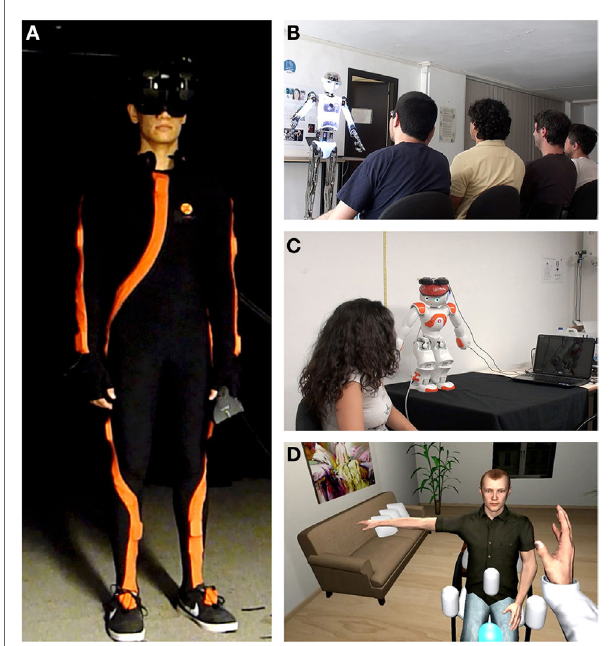
FigUre 4 | images from the transporter and all three destinations . Clockwise from left: (a) the visitor wears the Xsens Inertial motion capture suit and the NVIS nVisor SX111 HMD at the transporter; (B) PD1 where the visitor gives a talk to four locals, while embodied in the Robothespian; (c) PD2 where the visitor is in control of a Nao and engages in a friendly, social conversation with a friend; (D) VD3 where the visitor assists a local in performing an exercise, while embodied in a virtual